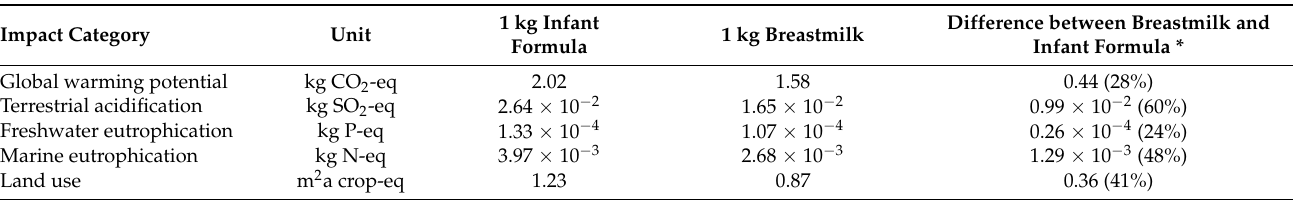
Table 3. Environmental impact from 1 kg ready-to-feed infant formula and 1 kg breastmilk, and the difference between the